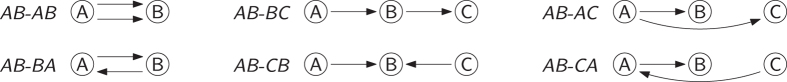
The six two-event temporal motifs studied.An arrow from A to B signifies that A reverted the content contributed by B. An arrow on top or to the left indicates an earlier event than an arrow on the bottom or to the right.